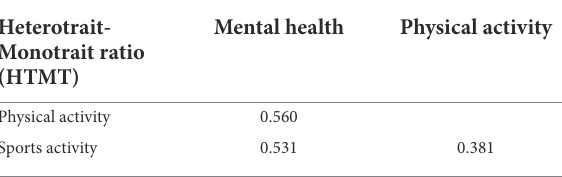
TABLE 4 Discriminant